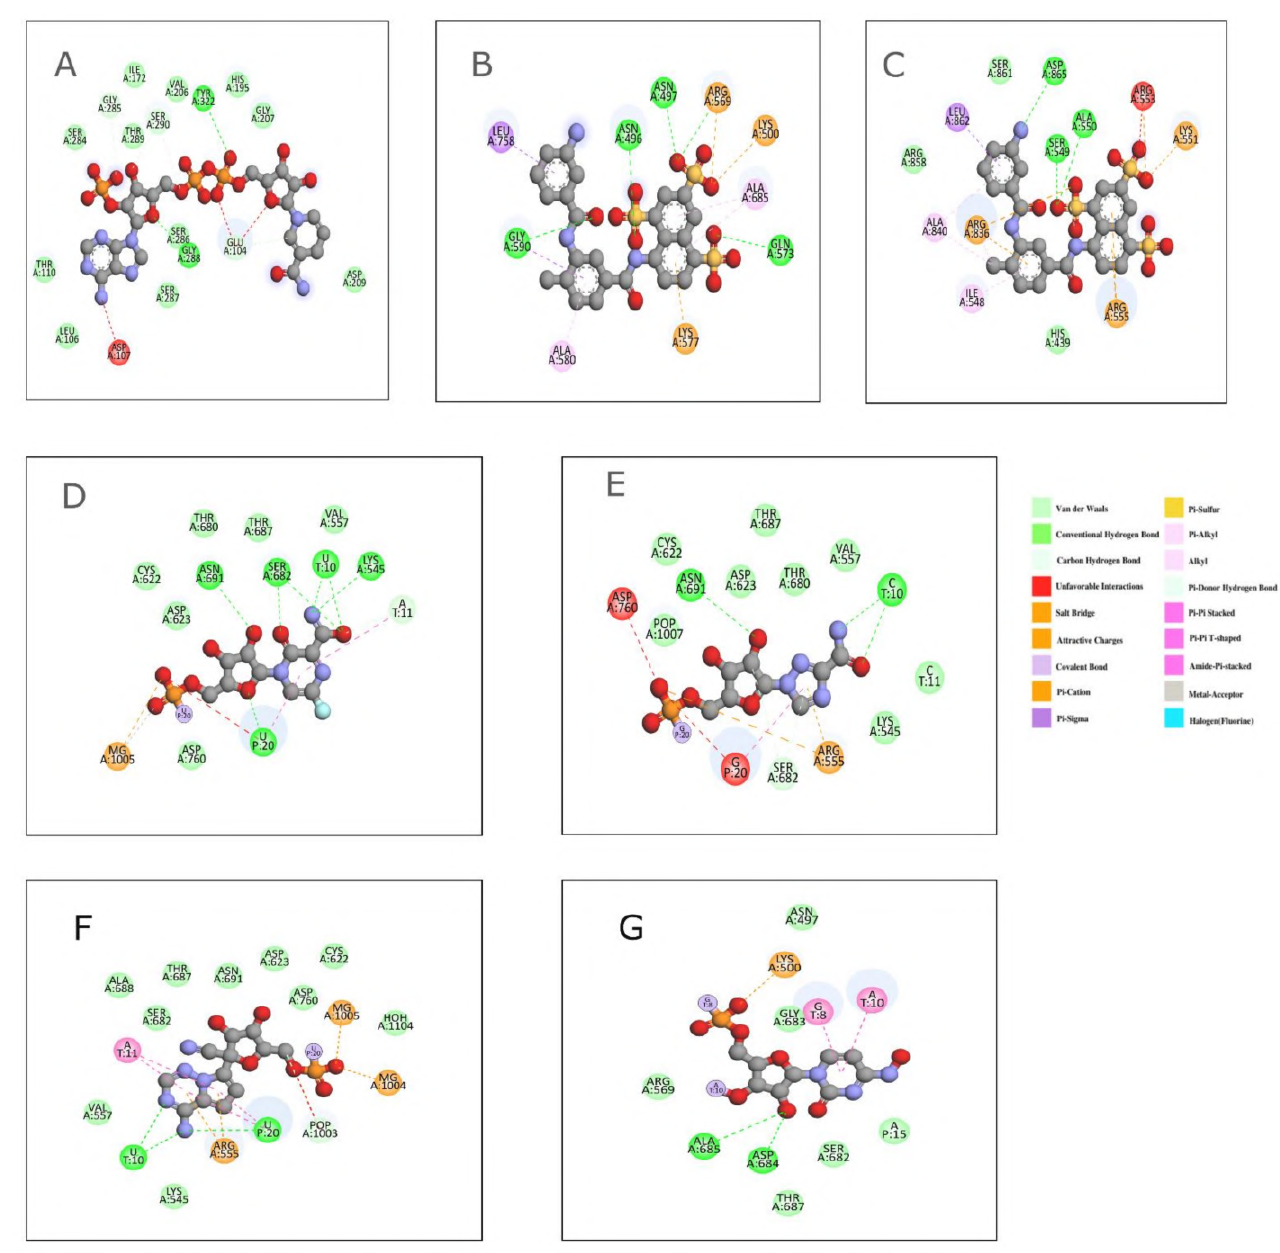
Figure 9. The ligand–RdRP interaction diagram for the Enterovirus and SARS-CoV-2 RdRPs with their inhibitor compounds. ( A ) Enterovirus D68 RdRP–NADPH (PDB 5ZIT), ( B ) SARS-CoV-2 RdRP– suramin (site 1) (PDB 7D4F), ( C ) SARS-CoV-2 RdRP–suramin (site 2) (PDB 7D4F), ( D ) SARS-CoV-2 RdRP–favipiravir (PDB 7DFG), ( E ) SARS-CoV-2 RdRP–ribavarin (PDB 7DFH), ( F ) SARS-CoV-2 RdRP–remdesivir (PDB 7BV2), ( G ) SARS-CoV-2 RdRP–molnupiravir (PDB